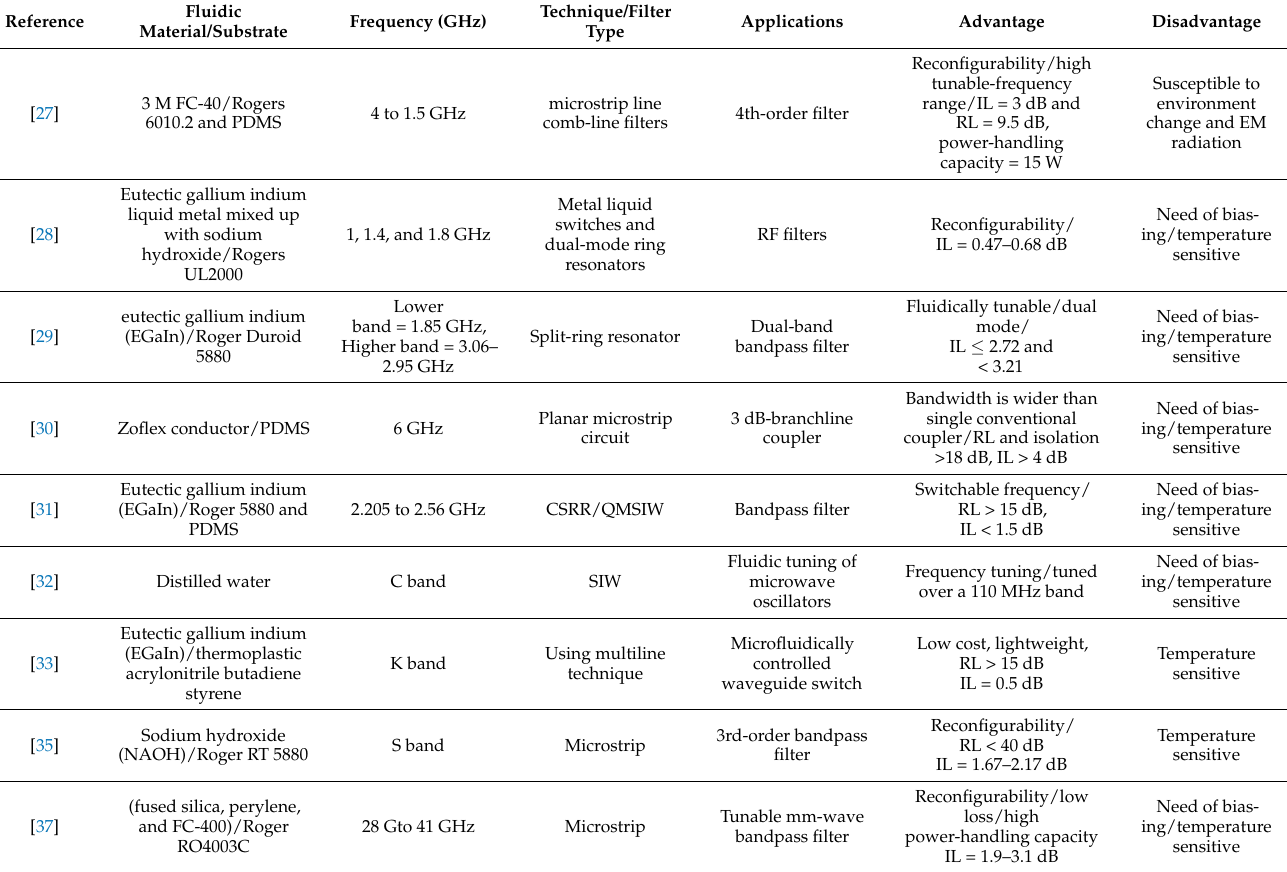
Table 2. Comparison analysis of microfluidic reconfigurable